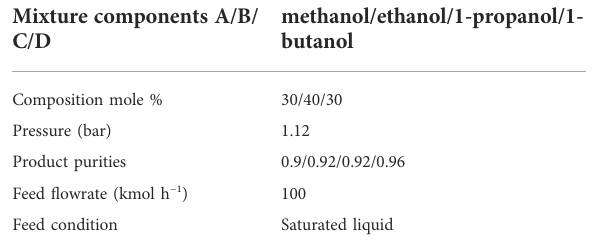
TABLE 12 Feed conditions for Example 5.